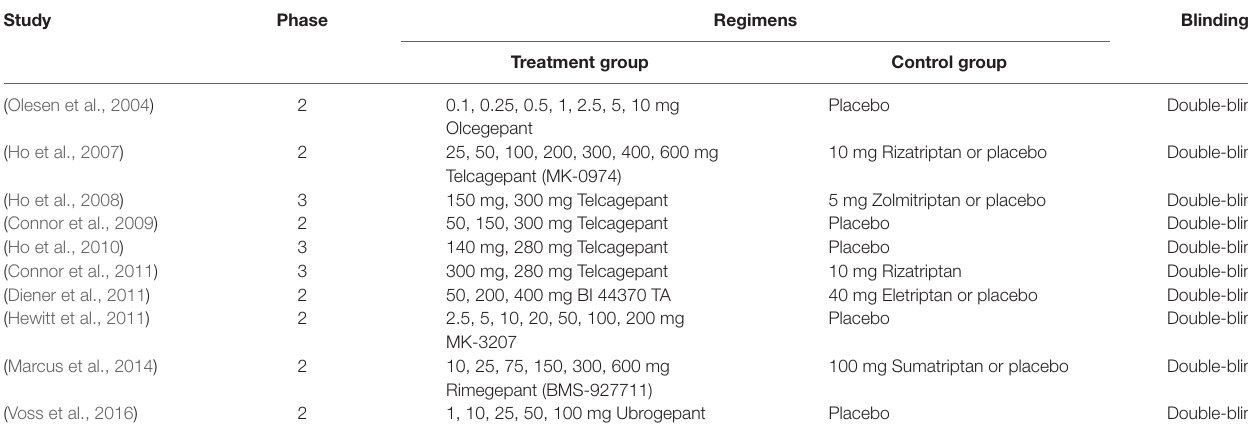
TABLE 2 | Characteristics of trials.